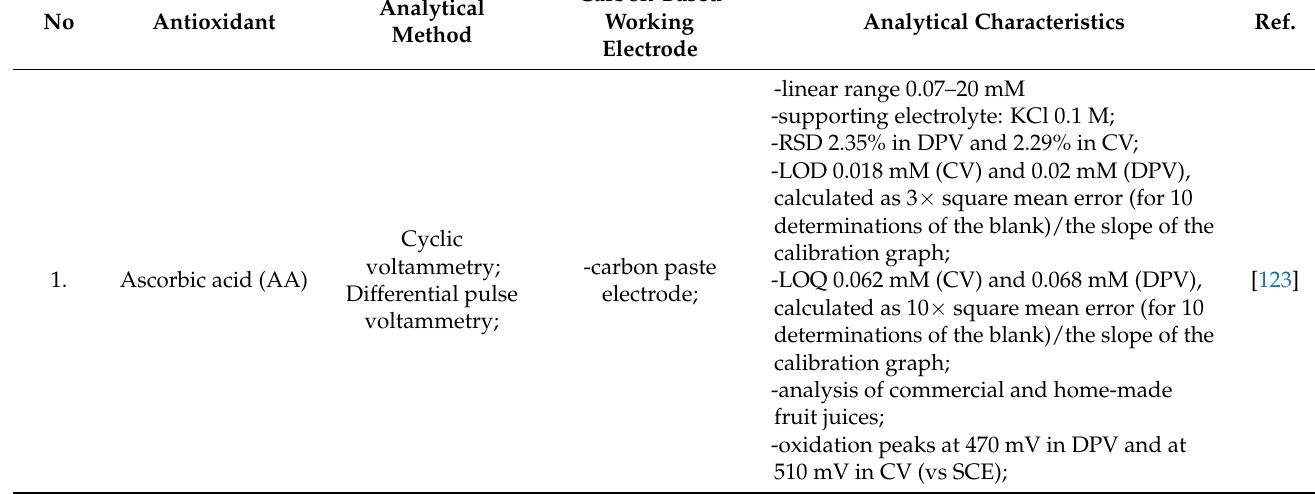
Table 2. Electroanalytical techniques applied to the assay of key individual antioxidants [123–167]. Carbon-Based Analytical No Antioxidant Working Analytical Characteristics Method Electrode